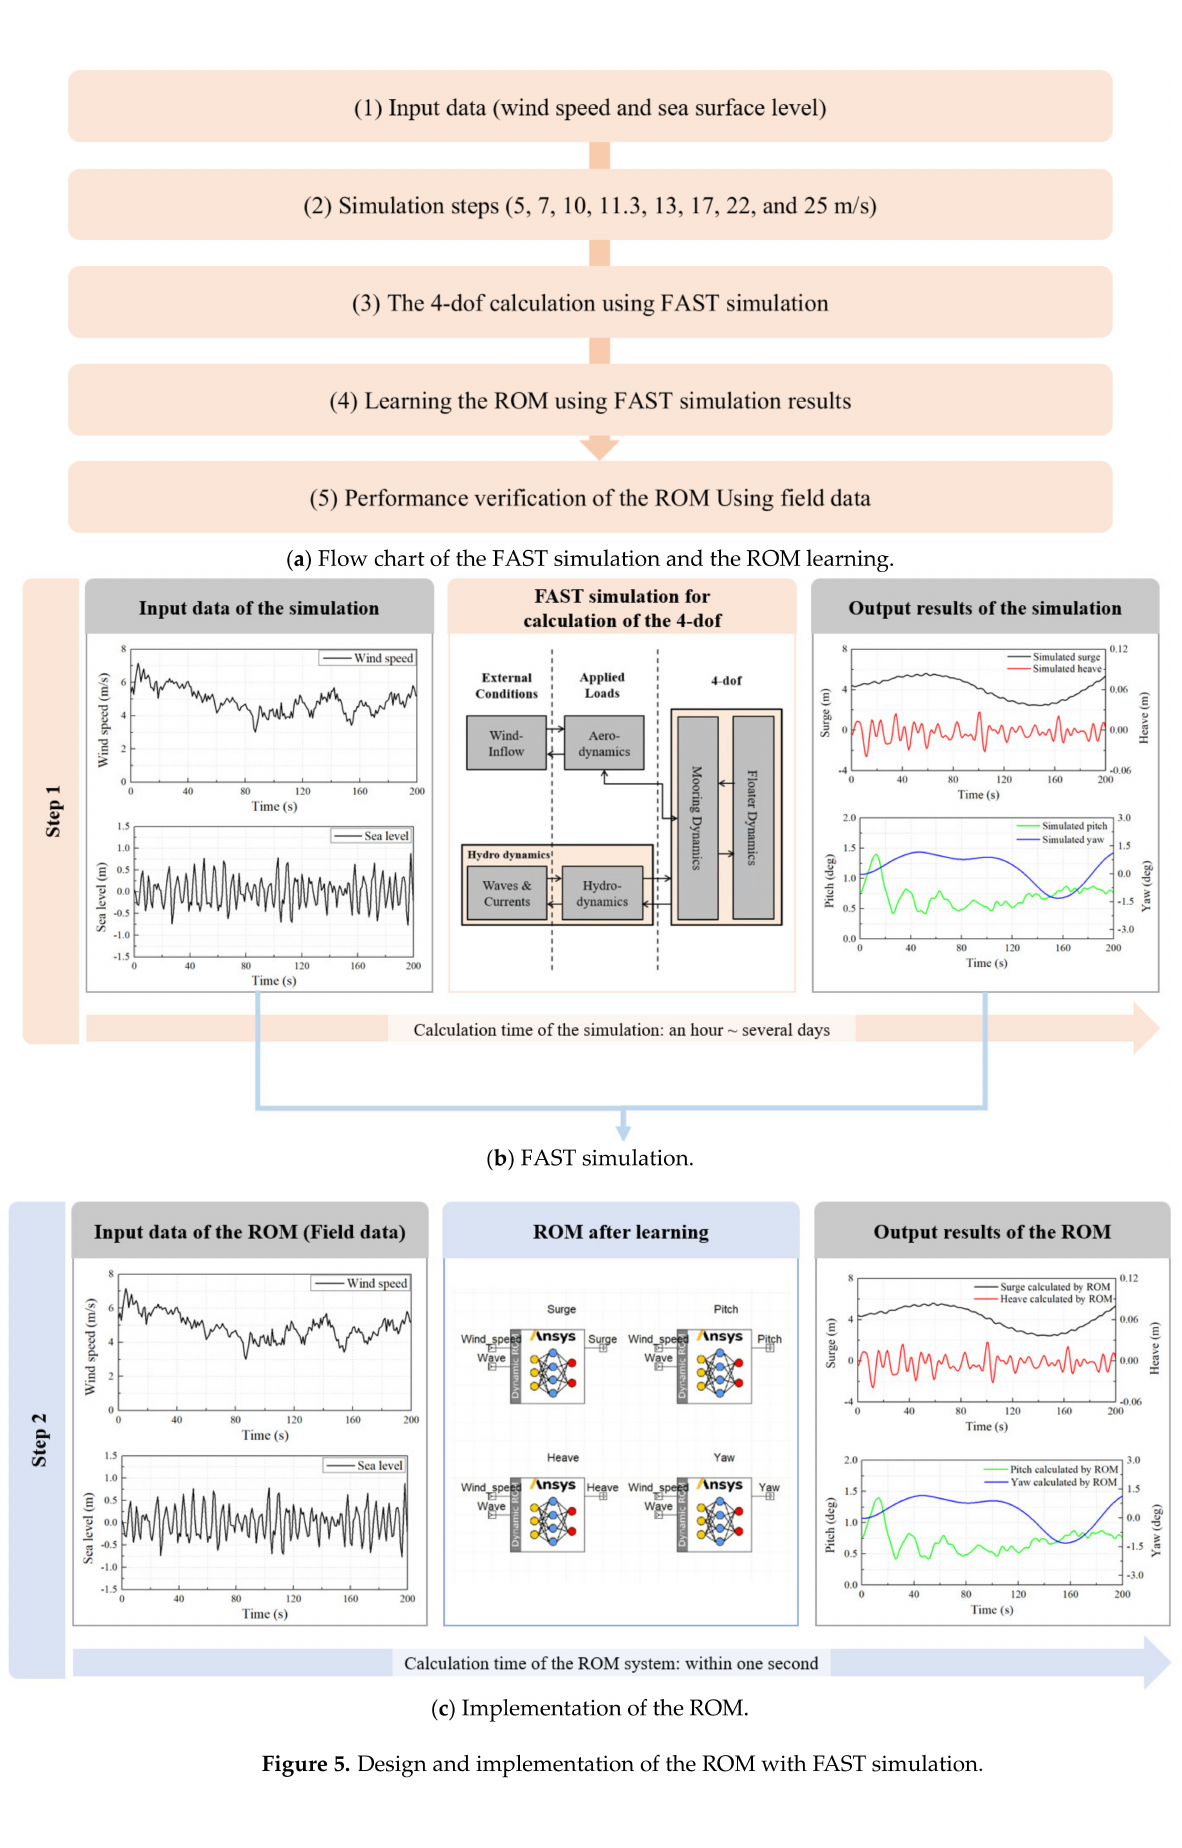
Figure 5. Design and implementation of the ROM with FAST